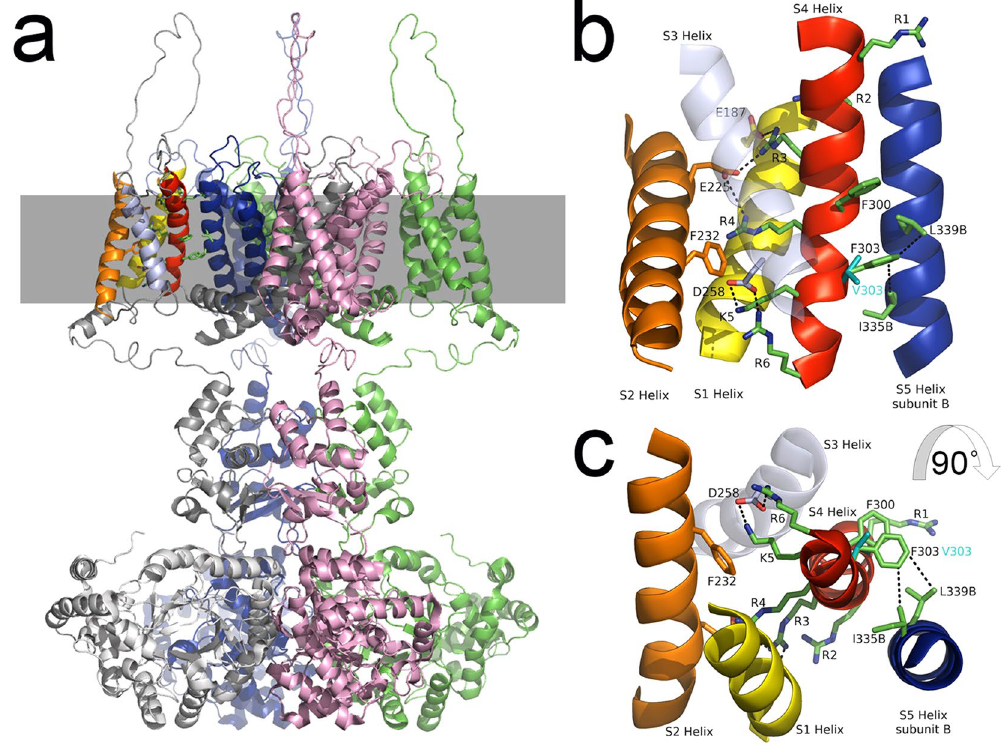
Figure 8. Model structure of the human Kv1.1 potassium channel in the open-state. ( a ) The structure of the tetrameric channel is shown with each of the four polypeptide subunits colored overall grey, green, pink and blue. The position of the membrane is illustrated by a grey band and the brightly colored helices in the top left of the figure are shown in the expanded Figures b and c. ( b ) The membrane spanning region of interest depicting four helices of one subunit (S1 yellow, S2 orange, S3 lavender and S4 red) and one helix from a neighboring subunit (S5B, blue) are shown. Helix S3 lies in front of the other helices and is rendered transparent for clarity. Significant side chains are drawn in stick representations and binding partners indicated by black dotted lines between them. These include R3-E187, R3-E225, R4-E225, K5-D258, R6-D258, F303-L339B and F303-I335B. The predicted position of the V303 mutant side chain is also shown. ( c ) Illustrates the same structure as depicted in B rotated ninety degrees towards the observer. The stacking of F300 and F303 is well illustrated in this